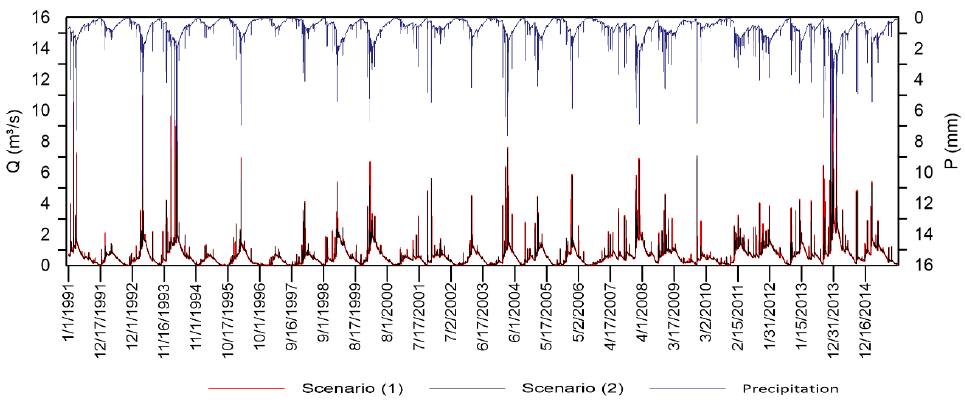
Figure 7. 24 h precipitation and simulated flows at the basin exit for LULC scenarios (1) and (2). Surface runoff (annual average) decreased by 1.37%, due to the increase in forest and shrub vegetation areas and the decrease in agricultural cover. The flow duration curves (FDC) (Figure 8) show that, for the 2019 coverage scenario, there is a flow of 0.3228 m³/s with a 90% probability of exceedance, while for the 2029 scenario it is 0.328 m³/s. The flow regime with a 90% probability of exceedance is 1.85% (7.72 l/s) higher for the 2029 than it is for the 2019. This trend has found up to a 1% probability of exceedance, reaching an increase of 1.05%.